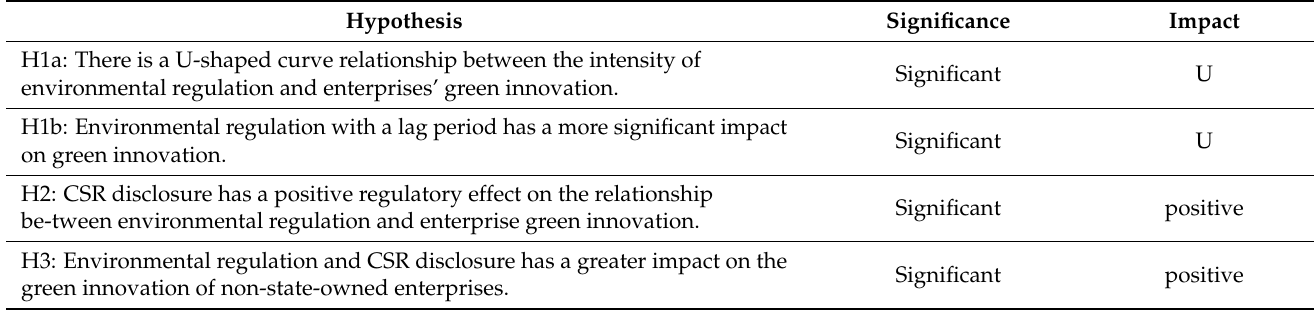
Figure 5. The regulatory effect diagram of non-state-owned enterprises’ social responsibility informa- tion disclosure. Table 5. Results of the hypothesis